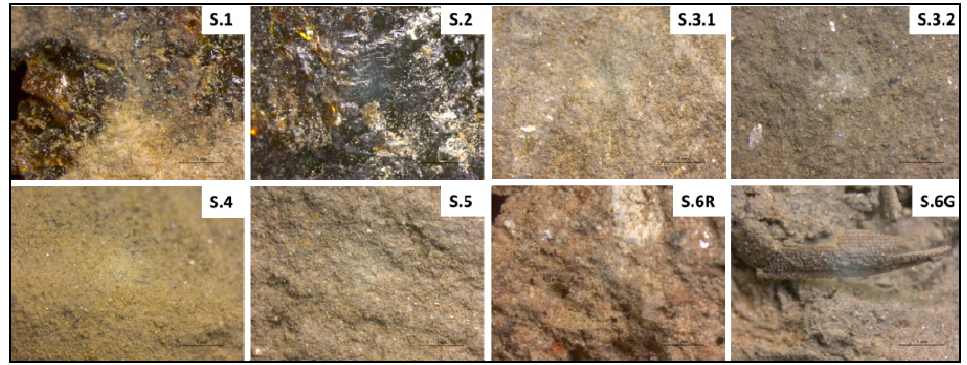
Figure 3. Images from stereozoom microscope of polished cross-sections of mortar samples (2.5× magnification).